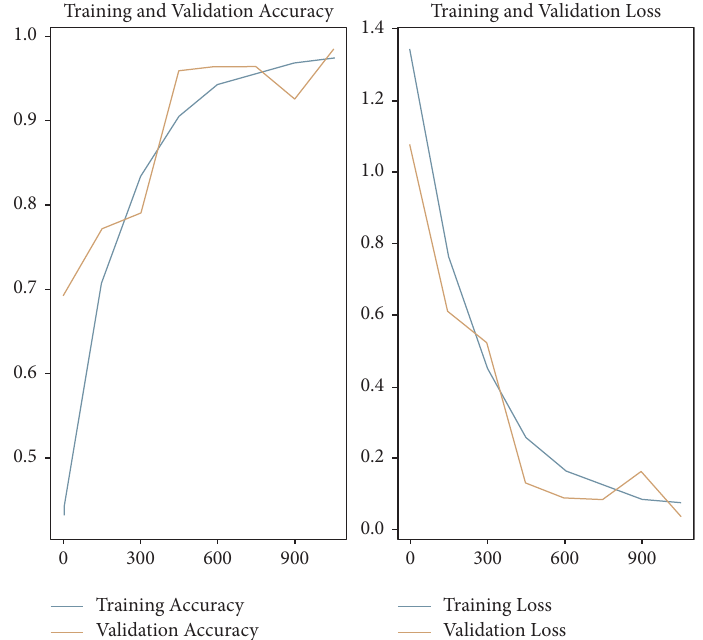
Figure 5: Performance graph of training on CASIA-B